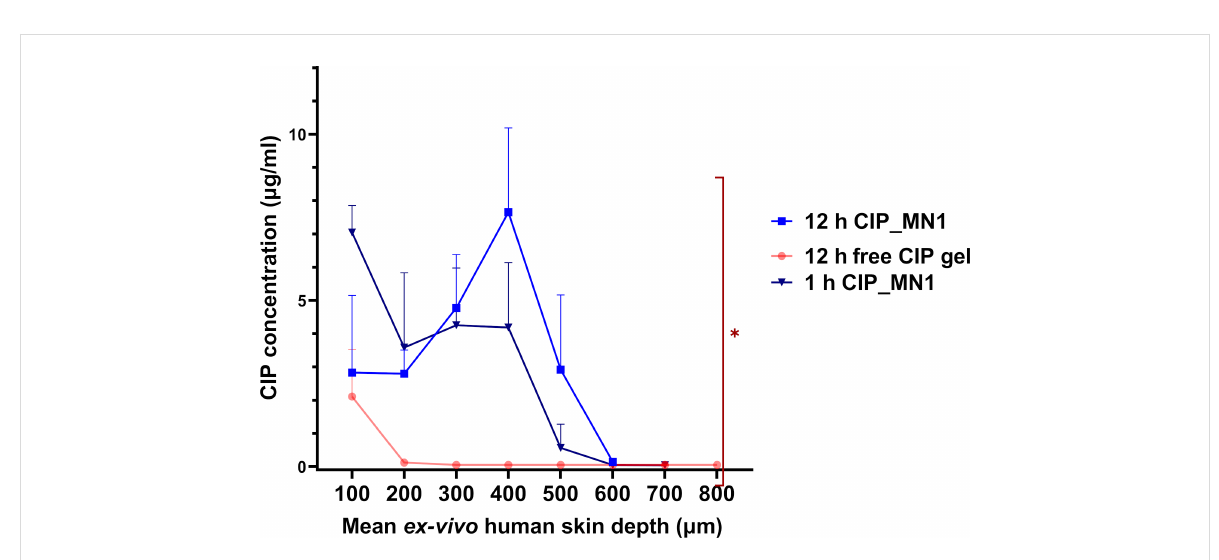
Figure 7: Ciprofloxacin skin deposition from CIP_MN1 after 1 h and 12 h from insertion, and from free gel after 12 h from application, into different depth distances. * P < 0.05 for one-way ANOVA between 12 h CIP_MN1, 1 h CIP_MN1, and free CIP gel; n = 4.